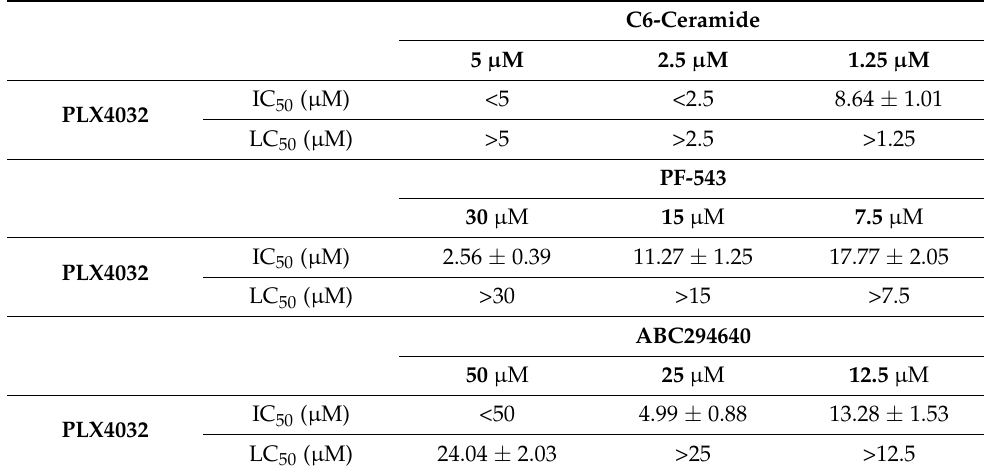
Table 1. IC 50 and LC 50 values of tested agents obtained by the MTT assay in resistant RKOr cell